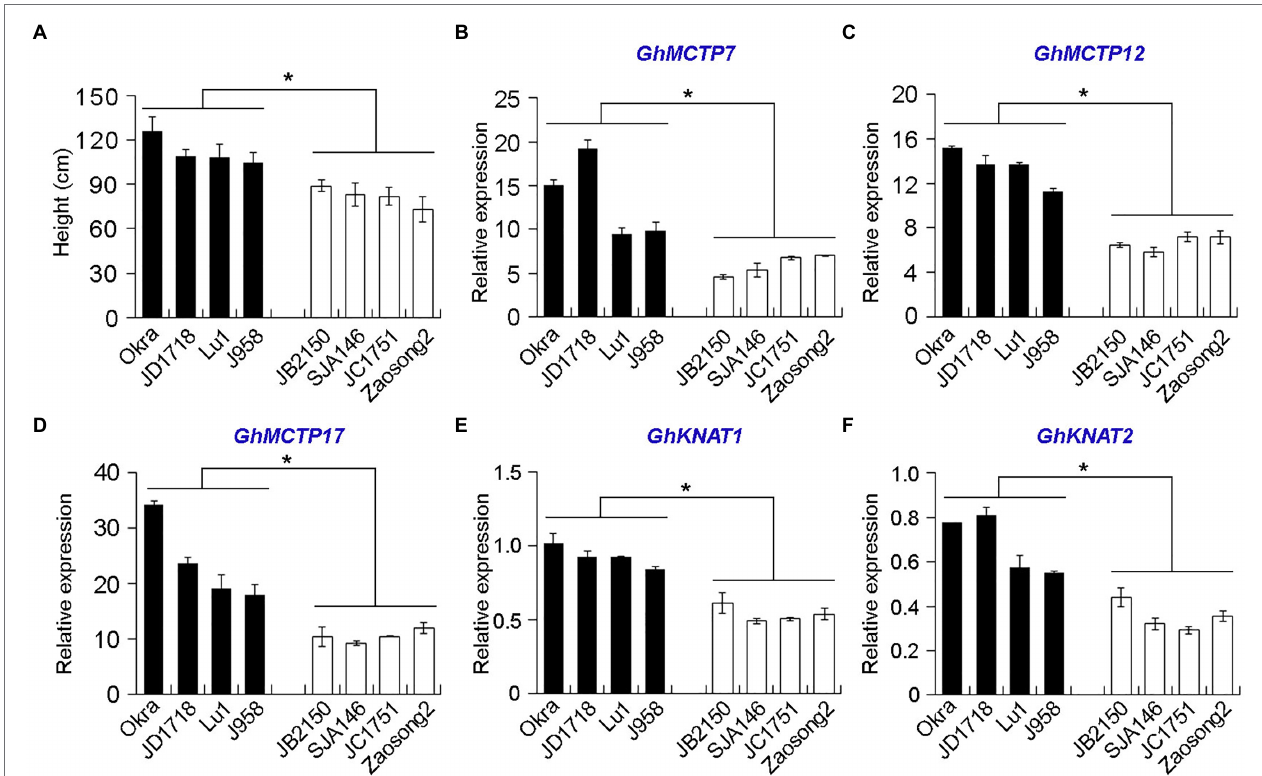
FIGURE 4 | The expression levels of GhMCTP7/12/17 and GhKNAT1/2 are correlated with the average plant height (cm) of cotton varieties. (A) Comparison of plant height of eight allotetraploid cotton cultivars ( G. hirsutun ). The heights of plants are calculated when cotton bolls were opening. The cotton varieties are divided into two groups according to their plant heights. The varieties over 100 cm in height or under 100 cm are grouped and are shown in black bars or white bars, respectively. (B-F) Quantitative real-time PCR analysis of GhMCTP7 (B) , GhMCTP12 (C) , GhMCTP17 (D) , GhKNAT1 (E) , and GhKNAT2 (F) in main stem apex of different cotton species. The X-axis represents different upland cotton species, while the Y-axis represents gene relative expressions. Results were normalized against the expression level of GhUBI1 . Error bars indicate SD of three biological replicates (* p <